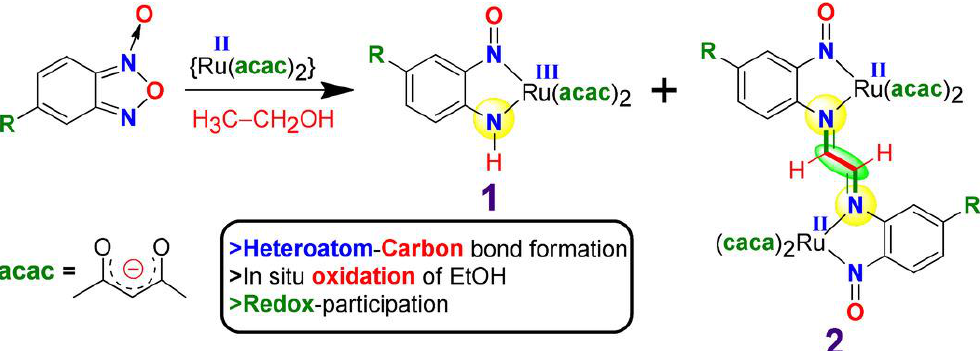
Figure 6. In situ solvent-mediated conversion of benzofuroxan affording 1,2-diimine non-innocent